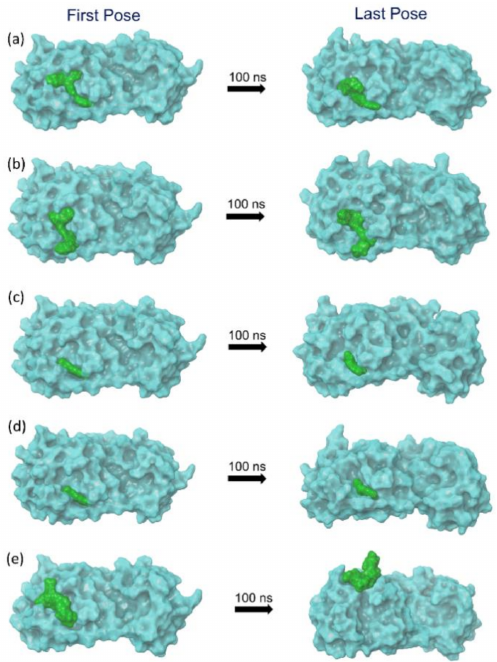
Figure 2. The 3D docked poses of SARS-CoV-2 M pro- bioactive compounds, namely natural products: ( a ) licuraside, ( b ) glucoliquiritin apioside, ( c ) 7,3 (cid:48) -Dihydroxy-5 (cid:48) -methoxyisoflavone, ( d ) licuroside, ( e ) glycyrrhizin, displaying the change in ligand conformation in the active pocket of SARS-CoV-2 M pro during a 100 ns MD simulation